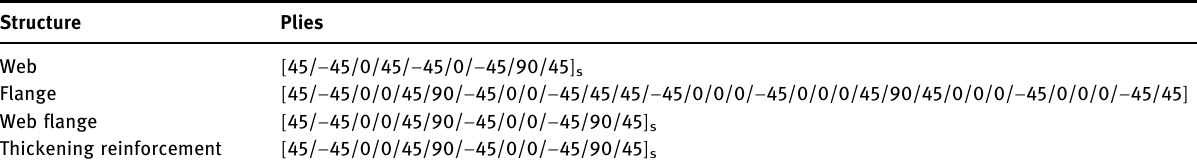
Table 1: The composite skins with di ff erent con fi guration Structure